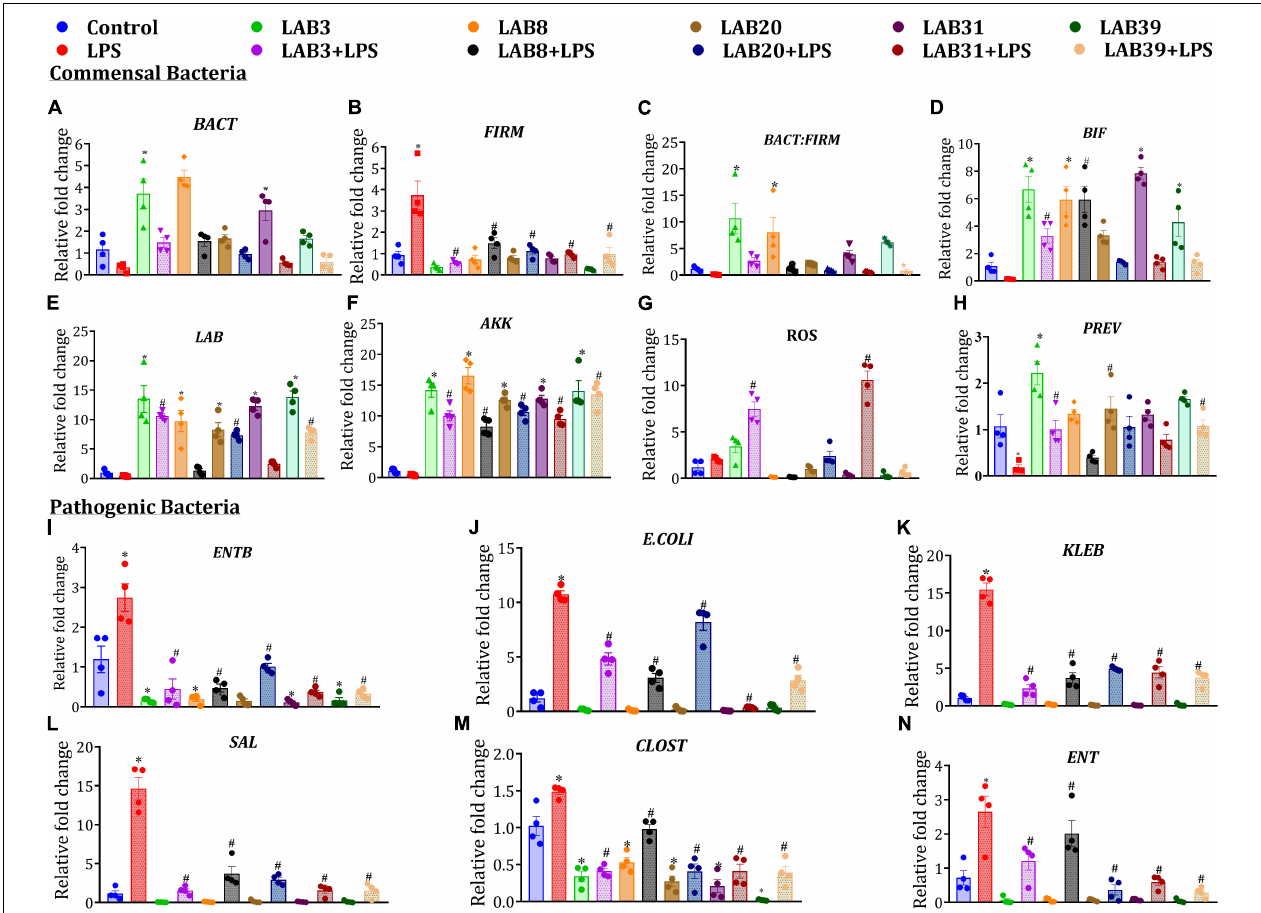
FIGURE 7 | Effect of LAB supplementation on the selected gut bacterial abundances: (A) BACT ; (B) FIRM ; (C) BACT: FIRM ; (D) BIF ; (E) LAB ; (F) AKK ; (G) ROS ; (H) PREV ; (I) ENTB ; (J) E. coli ; (K) KLEB ; (L) SAL ; (M) CLOST ; and (N) ENT . Data were analyzed by one-way ANOVA with Tukey’s post hoc test ( P ≤ 0.05) and are represented as mean ± SEM ( N = 4). LAB , Lactobacillus ; BIF , Bifidobacteria ; ROS , Roseburia ; AKK , Akkermansia ; FIRM , Firmicutes ; BACT , Bacteroidetes ; PREV , Prevotella ; E. coli ; KLEB , Klebsiella ; SAL , Salmonella; ENTB , Enterobacteriaceae ; CLOST , Clostridium ; ENT , Enterobacter. ∗ Significant relative to control; # significant relative to LPS group ( N =